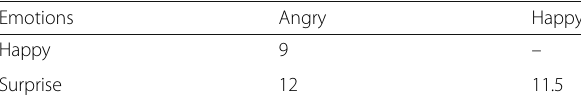
Table 1 Recognition confusion matrix of six emotions (%) Emotions